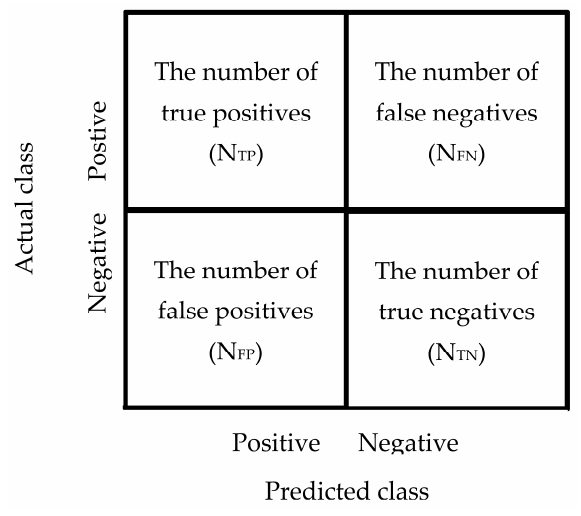
Figure 7. The confused matrix and the element